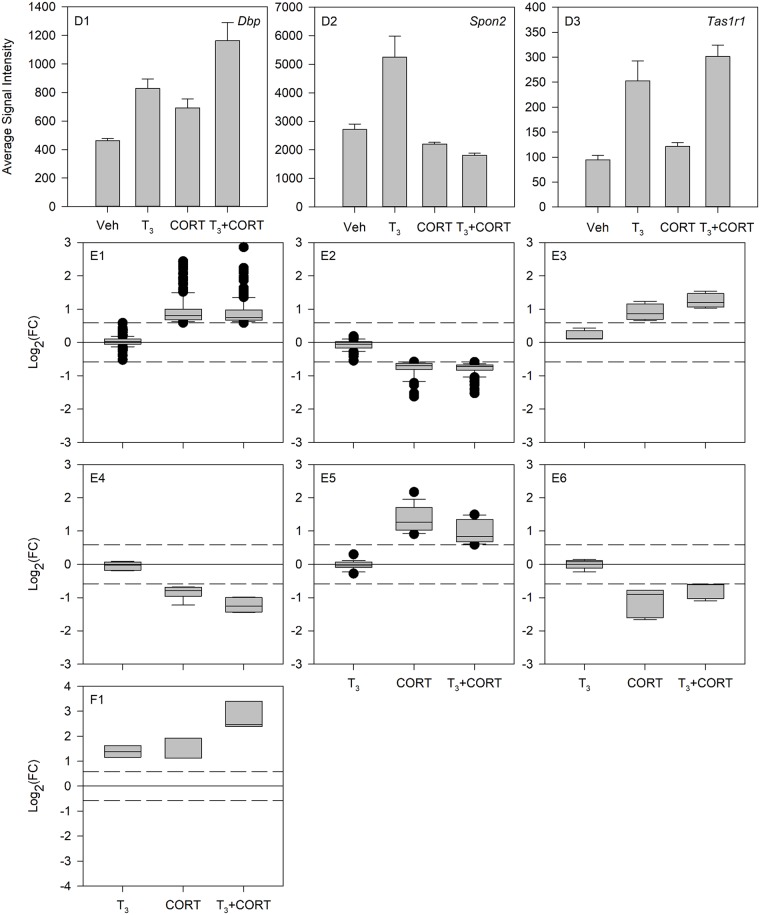
Generalized expression patterns of genes differentially expressed in more than one hormone treatment.Bar plots and box plots were created to represent the different regulation patterns of genes differentially expressed in T3 and T3 + CORT (D1-3), CORT and T3 + CORT (E1-6), and T3, CORT, and T3 + CORT (F1). For D1-3, gene expression is plotted in mean array signal value ± standard deviation per hormone treatment (Vehicle, T3, CORT, and T3+CORT). For E1-6 and F1, the Log2 of the fold-change value per gene was plotted in box plots. The box plots show the median, 10th, 25th, 75th, and 90th percentile as vertical boxes with error bars. Black circles represent outliers in the data set. The dashed lines represent the Log2 of 1.5 fold-change cut-off for differential expression.